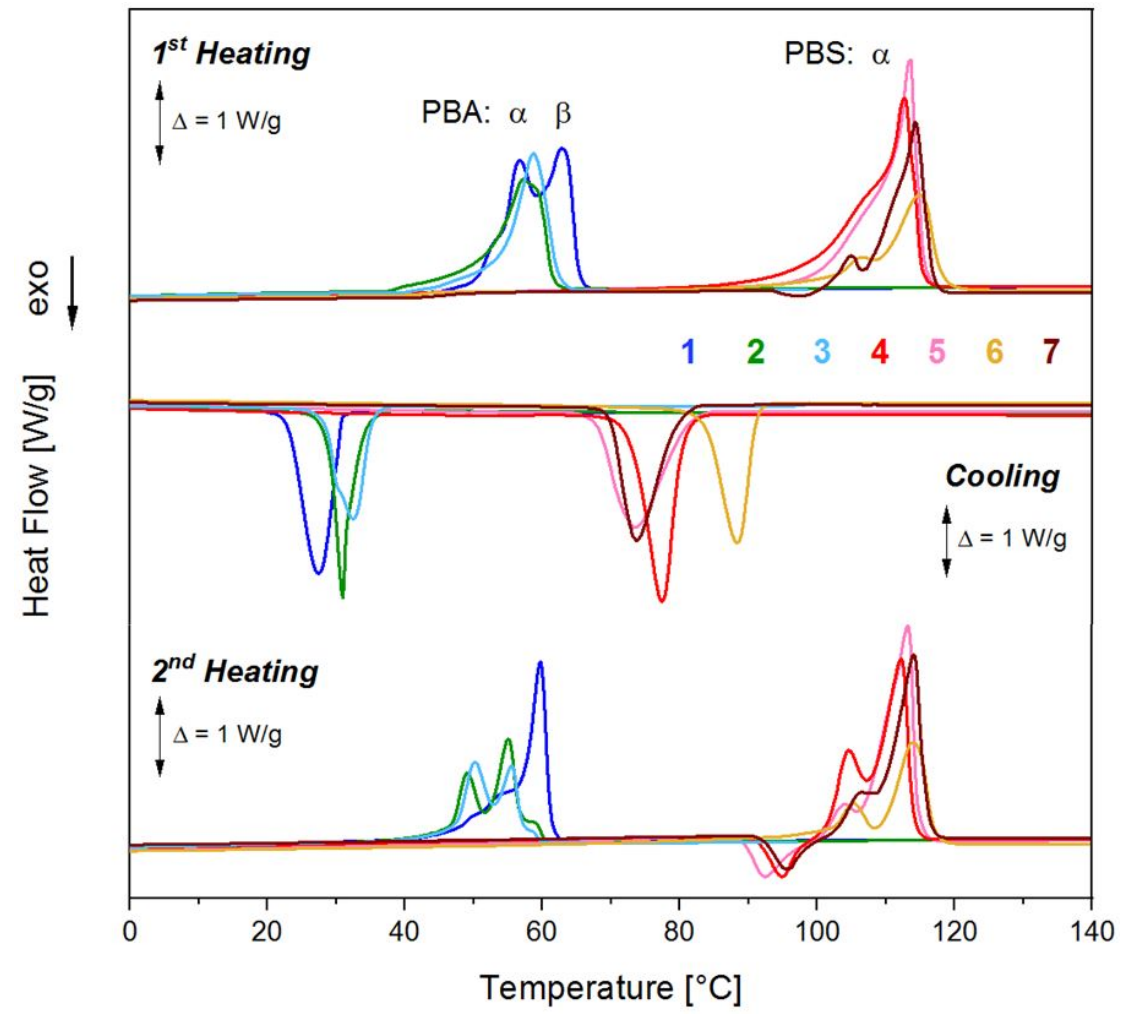
Figure 6. DSC curves (1st heating, cooling, 2nd heating) of PBA and PBS samples obtained by enzymatic polycondensation with CALB in solution and in melt compared to samples from conventional melt polycondensation: ( 1 ) PBA4 in solution; ( 2 ) PBA7 in melt with CALB; ( 3 ) PBA9 in melt Ti(OBu) 4 ; ( 4 ) PBS5 in solution; ( 5 ) PBS8 in melt with CALB; ( 6 ) PBS1 in melt with Ti(OBu) 4 ; and ( 7 ) PBS1-3 in melt with Ti(OBu) 4 with higher molar mass.